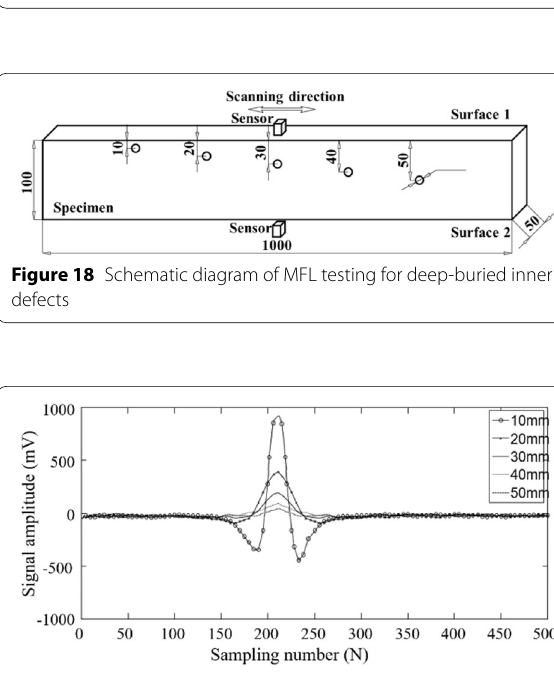
Figure 19 The normal components of the MFL generated by inner defects with buried depths (Sensor scanning above surface 1 indicated in Figure 18)